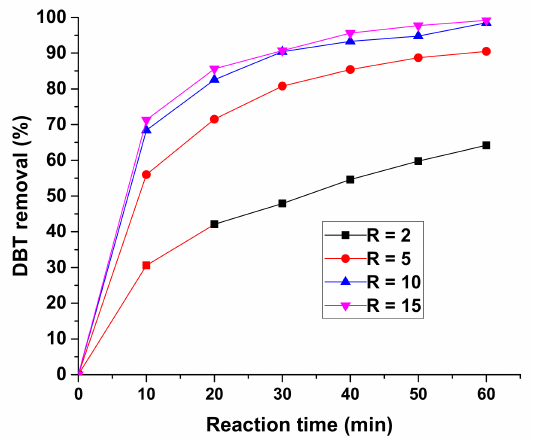
Figure 7. Effect of H 2 O 2 /dibenzothiophene (DBT) molar ratio on the 20 wt% V 2 O 5 /Zr-SBA-15. Reaction conditions: catalyst loading: 1 g/L oil; reaction temperature: 50 ◦ C; reaction time: 60 min; oil/acetonitrile volume ratio: